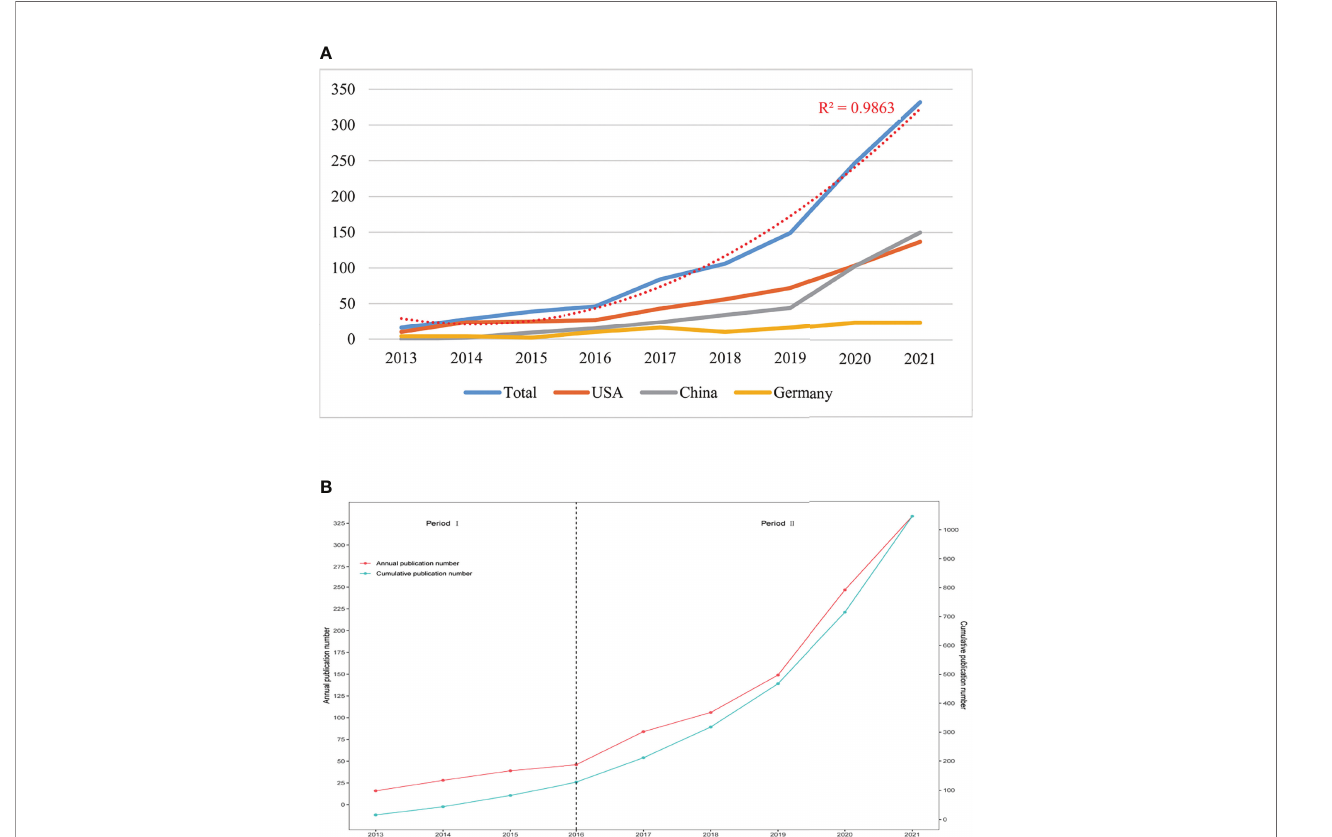
FIGURE 2 | (A) The total numbers of publications and top three countries from 2013 to 2021. (B) The numbers of publications by year and accumulation from 2013 to